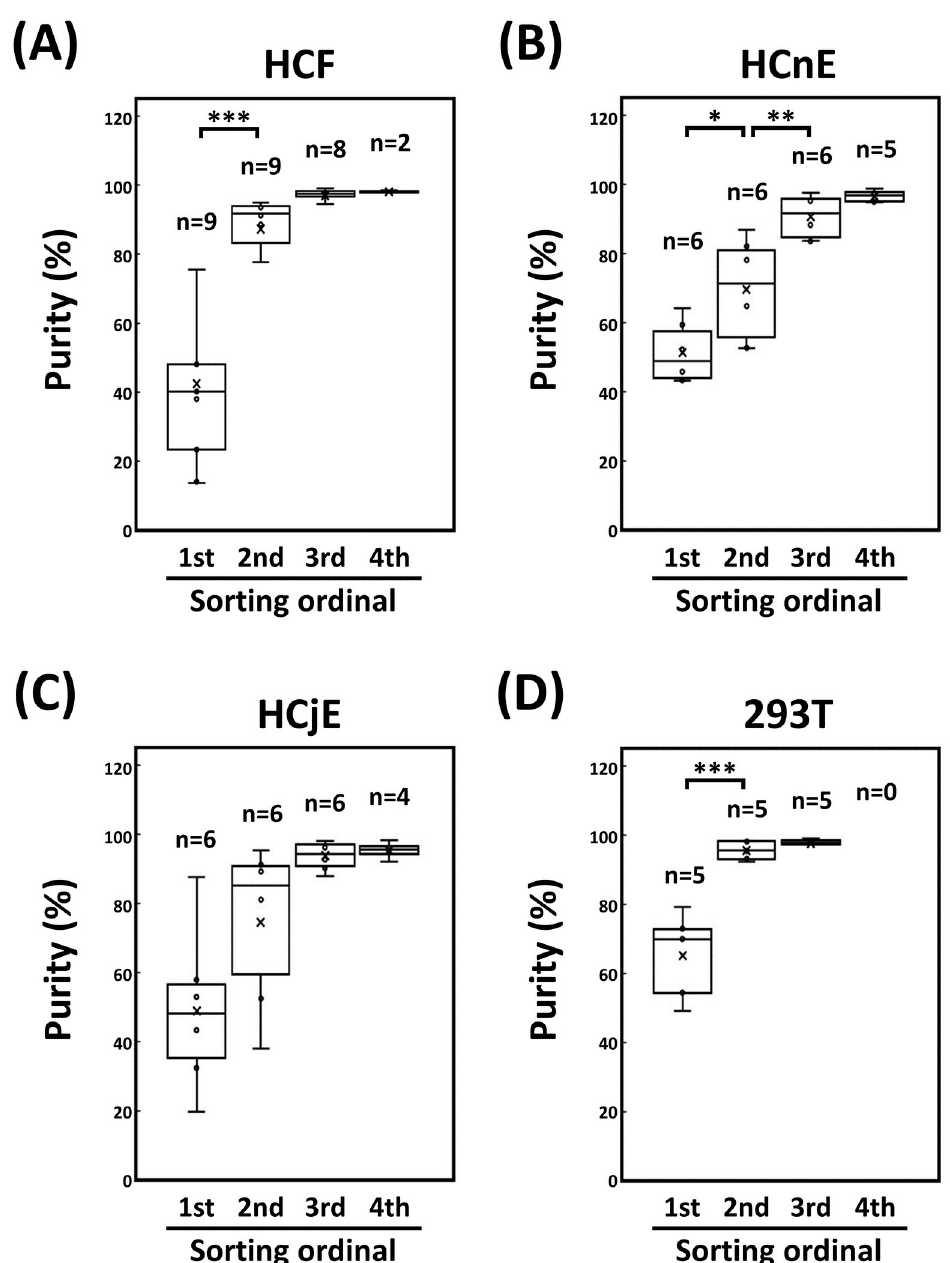
Fig 2. Purity of the EGFP-positive cells after sequential passaging and sorting. Each cell type was seeded into a 10-cm culture dish: (A) 2.0 × 10 5 HCFs, (B) 2.0 × 10 6 HCnEs, (C) 2.0 × 10 6 HCjEs, and (D) 2.0 × 10 6 HEK-293T cells. At 24 h post-seeding, each cell type was incubated EGFP-encoding pseudovirions at 5.0 × 10 6 R.T.U. for 16 h. Subsequently, the culture media were refreshed for each of the transduced cells until > 90% confluency was attained. The transduced cells were analyzed and sorted with a cell sorter at the indicated rounds. All rounds of cell sorting were repeated until the proportion of EGFP-positive cells was > 95% in two successive passages. Box-whisker plots were drawn to show the proportion of sorted cells expressing EGFP. The n values on the box-whisker plots represent the number of different donor corneas from which HCFs were harvested (A). The n values on the box-whisker plots represent the number of experiments performed at the indicated sorting times for HCnEs (B), HCjEs (C), and HEK- 293T cells (D). Horizontal lines represent the median, boxes denote the two inner quartiles, and whisker bars show the maximum and minimum values for expression efficiency. S2 Fig lists all the proportions of the EGFP-positive cells during cell sorting at the indicated rounds. Differences in the purity of EGFP-positive cells were analyzed separately by one-way analysis of variance followed by Tukey’s honestly significant difference post-hoc test ( � P < 0.05; �� P < 0.01; ��� P <